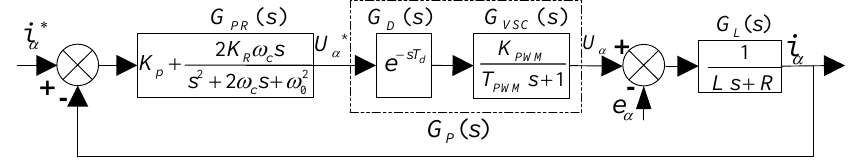
Figure 8. Control block diagram of the inner current loop.